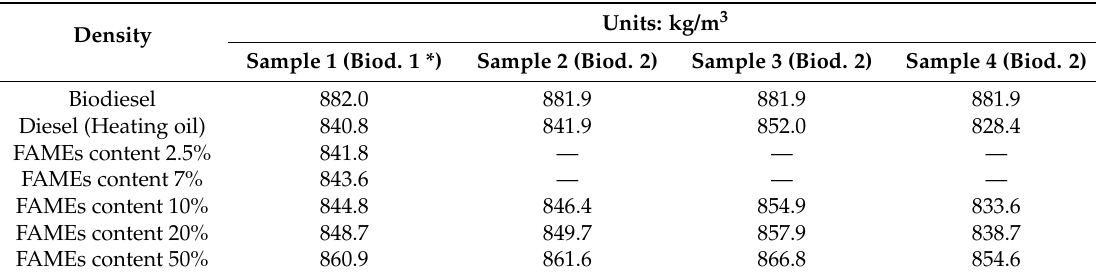
Table 4. Density of oil